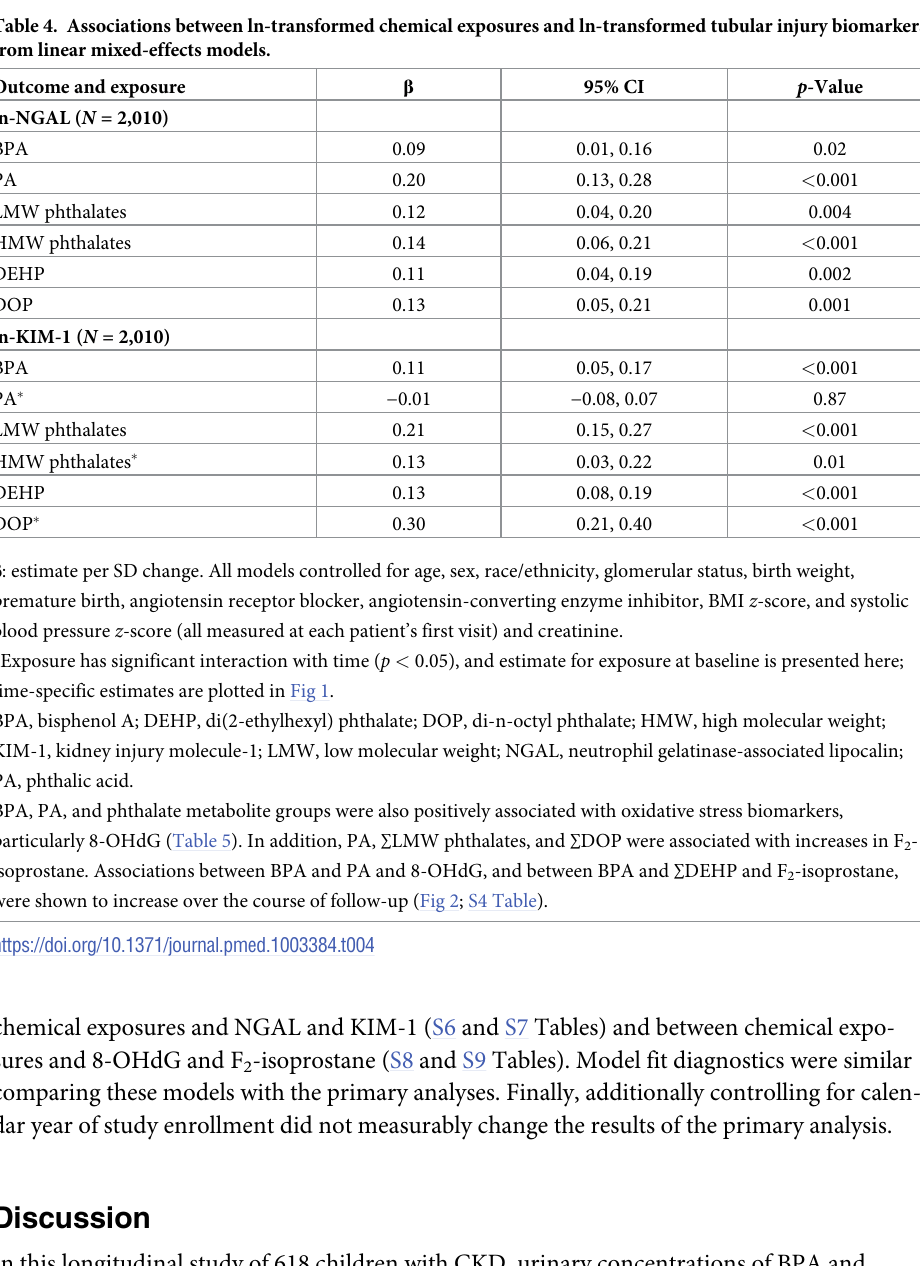
Table 4. Associations between ln-transformed chemical exposures and ln-transformed tubular injury biomarkers from linear mixed-effects models. Outcome and exposure β 95% CI p -Value